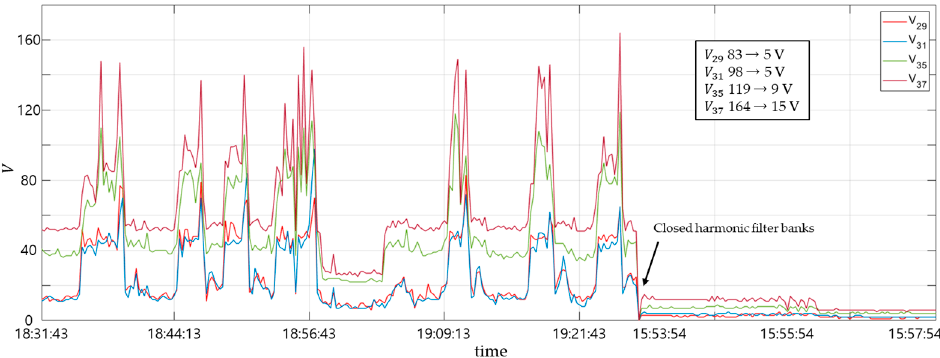
Figure 12. Measured 𝑉 (cid:3035)((cid:2869)(cid:2875),(cid:2869)(cid:2877),(cid:2870)(cid:2871),(cid:2870)(cid:2873)) on 22 kV system.